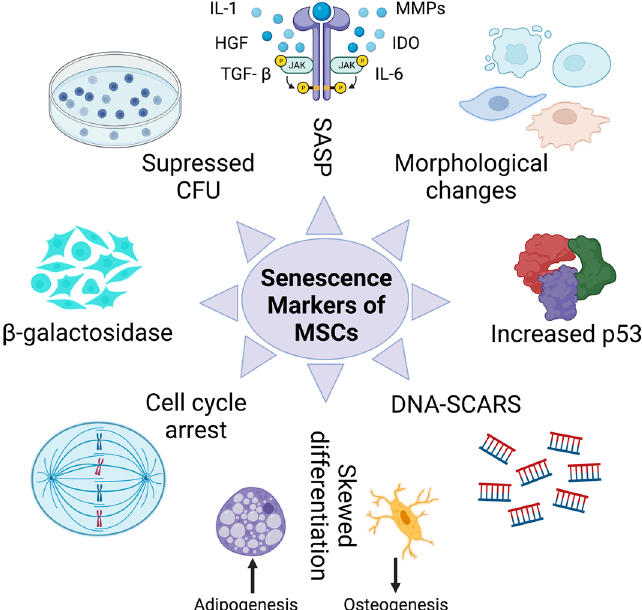
Fig. 4 Overview of replicative senescence markers in MSCs. The major markers of MSC aging in laboratory are DNA damage, P53 upregulation, SA‑β‑gal expression, morphological changes, cell‑cycle arrest, skewed differentiation, induced SASP, and compromised colony‑forming ability. Activate